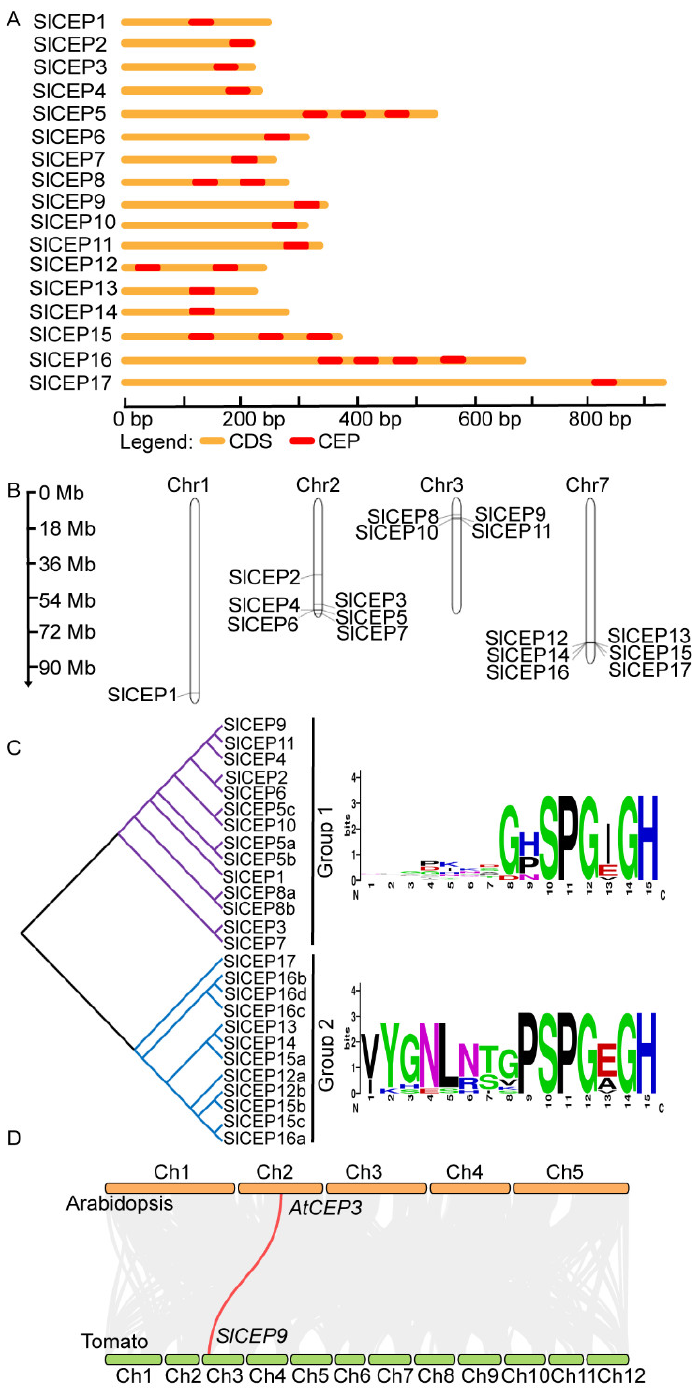
Figure 2. Genomic organization and chromosome localization, and phylogenetic analysis of SlCEP genes. ( A ) Gene structure of SlCEP genes. ( B ) Distribution of SlCEP genes on tomato chromosomes. ( C ) SlCEP proteins are classified into two major groups based on the CEP motifs. Weblogo showing the consensus sequence of CEP motifs in each subgroup. The phylogenetic tree was generated based on the CEP motifs of SlCEP proteins with 1000 bootstrap replicates. ( D ) The gene duplication analysis of the CEP genes of A. thaliana with S. lycopersicum . The gray lines (in the background) represent collinear blocks between the respective genomes. The red lines indicate the syntenic gene pairs of S. lycopersicum with A. thaliana .